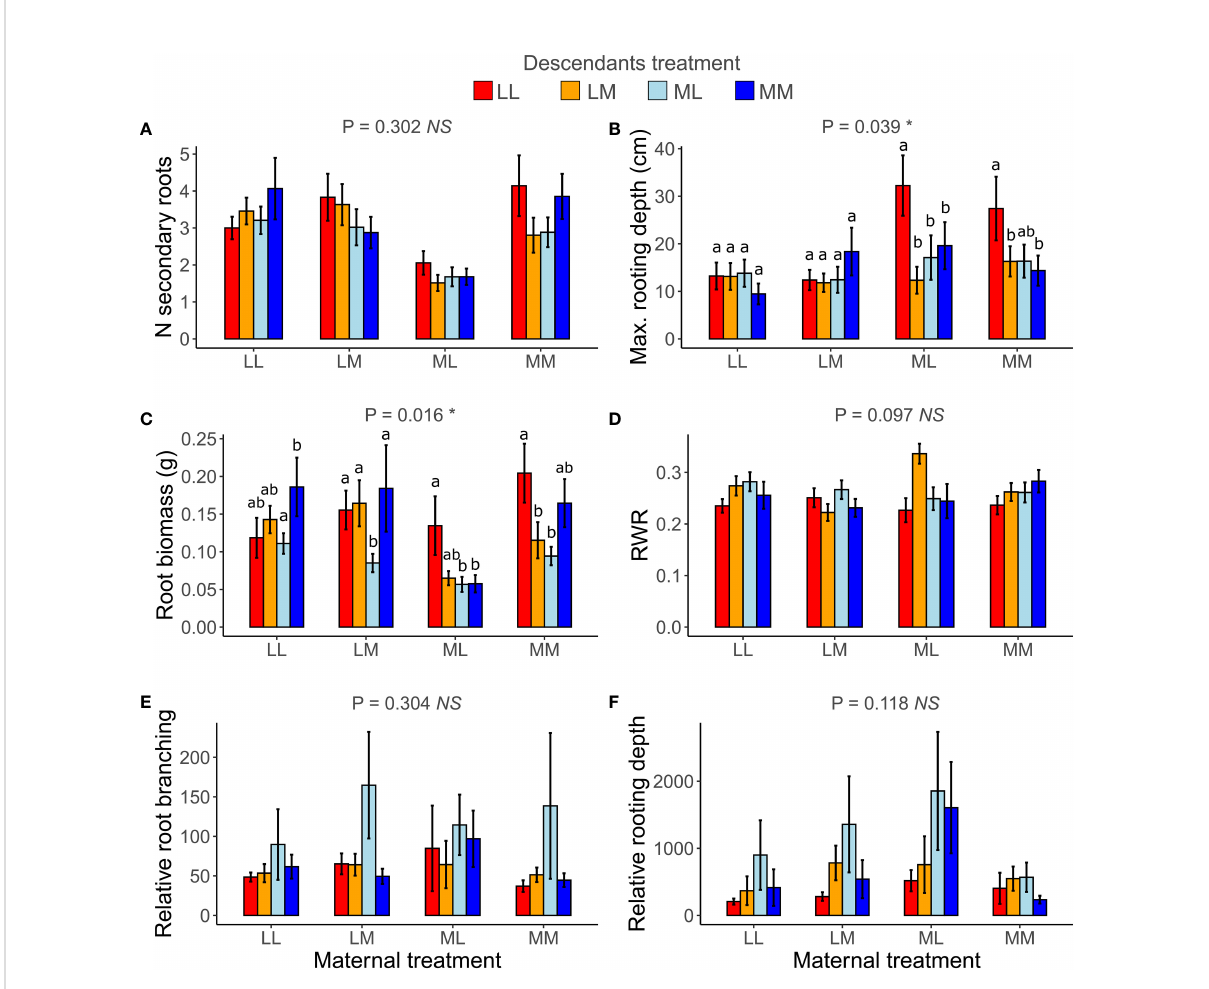
FIGURE 5 Transgenerational plasticity of roots in response to precipitation predictability treatments. Maternal treatment × Descendants treatment interaction in number ( N ) of secondary roots (A) , maximum (max.) rooting depth (B) , root biomass (C) , root weight ratio (RWR) (D) , relative root branching (E) , and relative rooting depth (F) . Means ± SE are shown in the bar plots. Signi fi cance of the Maternal treatment × Descendants treatment interaction is shown above each graph. Signi fi cant post-hoc contrasts among treatment combinations from the same maternal treatment are indicated with